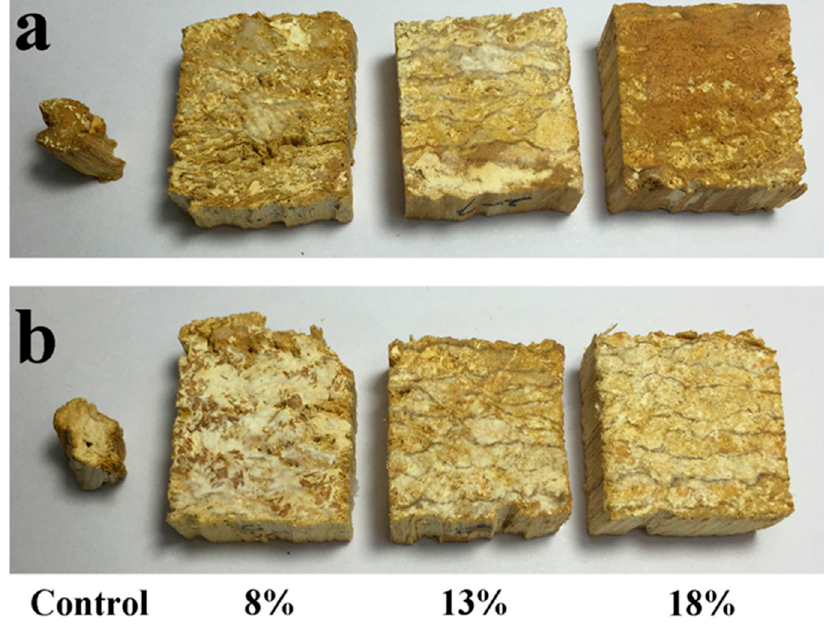
Figure 1. Photographs of wood reference samples (control) and outdoor wood mats-based engi- neering composite (OWMEC) samples with different resin contents (8%, 13%, and 18%) after 12 weeks of incubation. ( a ): T. versicolor decay; ( b ): G. trabeum decay.